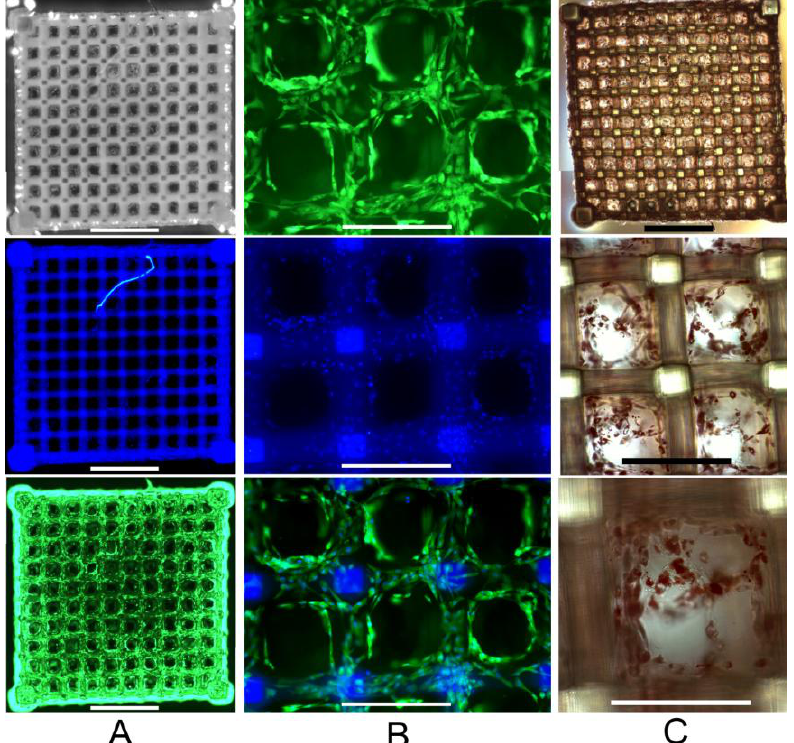
Figure 3. Human adipose-derived stem cells (ASCs) within the 2PP Scaffold at day 7; ( a ) Staining with Calcein AM ( i.e ., cell viability stain, green fluorescence) and Hoechst 33342 ( i.e ., cell nuclei stain, blue fluorescence) indicates the cell distribution (scale bars represent 1 mm); ( b ) Magnified scaffold view (scale bars represent 300 µm); ( c ) Oil Red O staining ( i.e ., indicator of intracellular lipid accumulation) (scale bars represent from top to bottom 1 mm, 300 µm and 200 µm